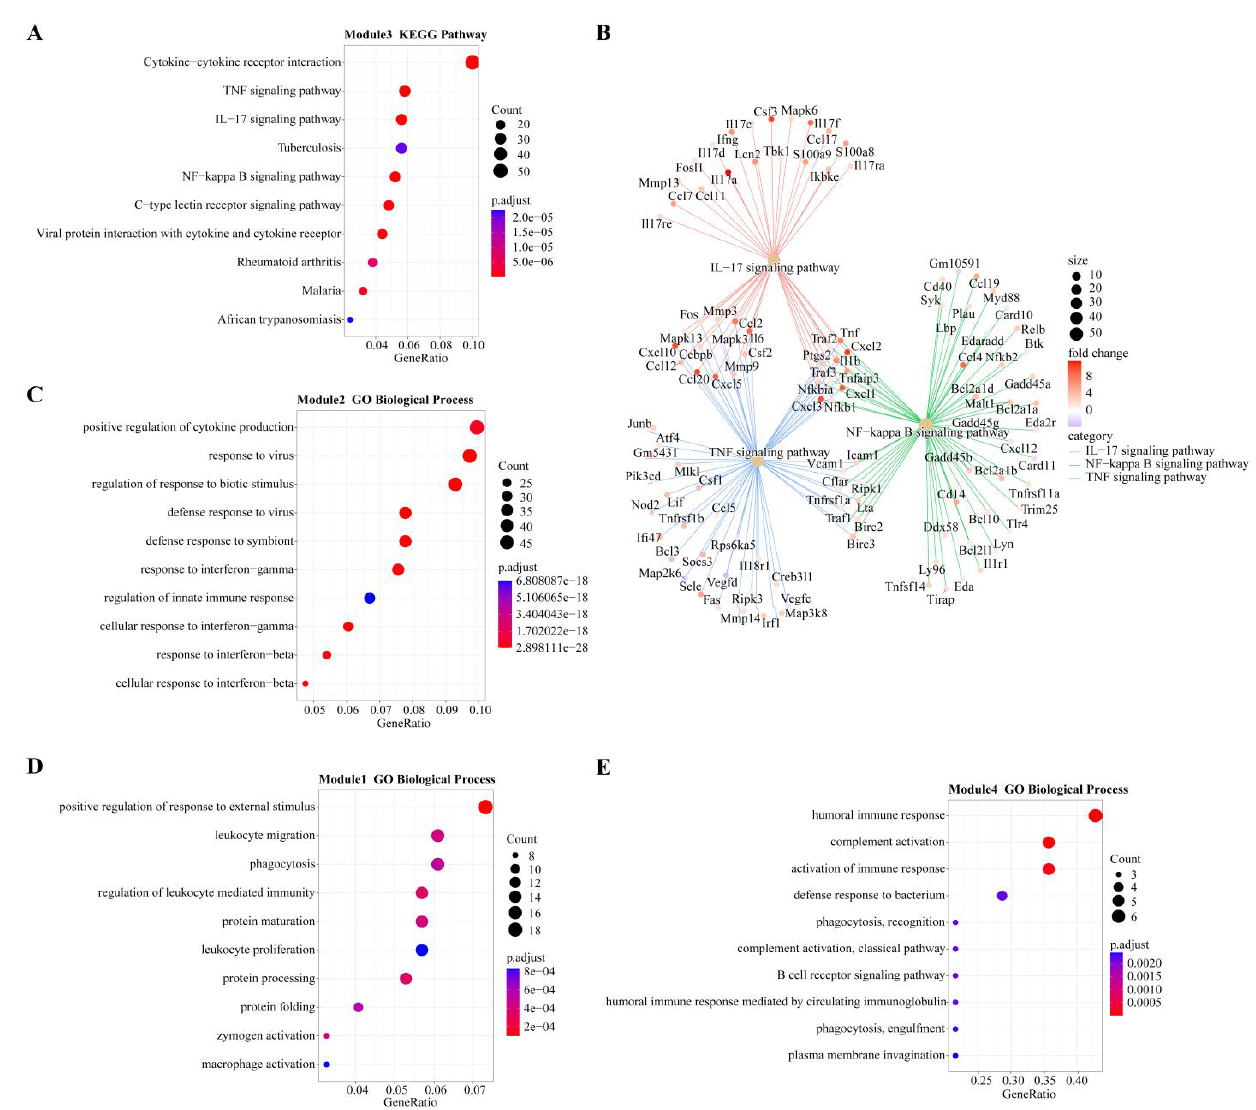
Figure 5. Overview of GO terms (biological process) or KEGG pathways within modules highly positively correlated with different infection stages. ( A ) KEGG pathways of module 3 (highly correlated with 12 hpi). ( B ) Genes involved in three important pathways and their expression levels at 12 hpi. Different colors represent different pathways: red for IL-17, green for NF- κ B, and blue for TNF. Fold change represents the change in gene expression level compared to 0 hpi (control group). ( C ) GO terms of module 2 (highly correlated with 24 hpi). ( D ) GO terms of module 1 (highly correlated with 48 hpi). ( E ). GO terms of Module 5 (highly correlated with 96 hpi).